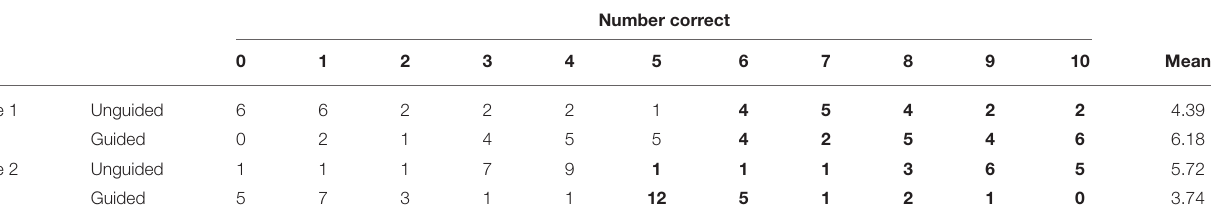
TABLE 2 | Possible datasets for the data in Table 1